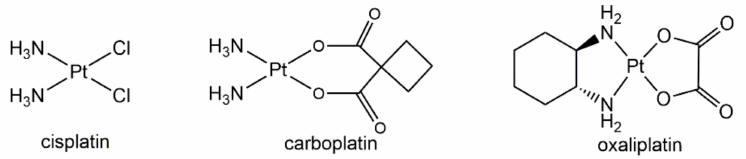
Figure 1. Chemical structure of cisplatin, carboplatin, and